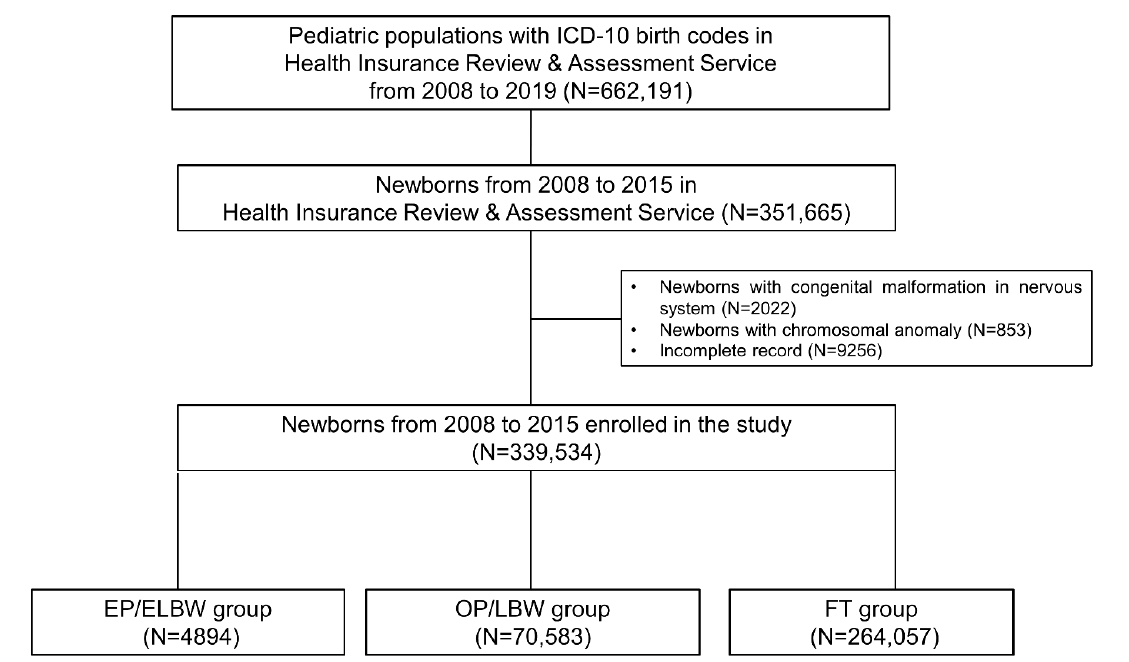
Figure 1. Flow chart of the study population. Abbreviations: ICD-10, the World Health Organization’s International Classification of Diseases 10th revision; EP, extremely preterm; ELBW, extremely low birth weight; OP, other preterm; LBW, low birth weight; FT, full-term.